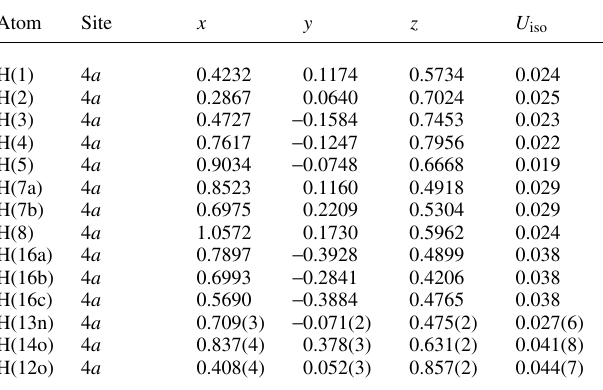
Table 2. Atomic coordinates and displacement parameters (in Å 2 )